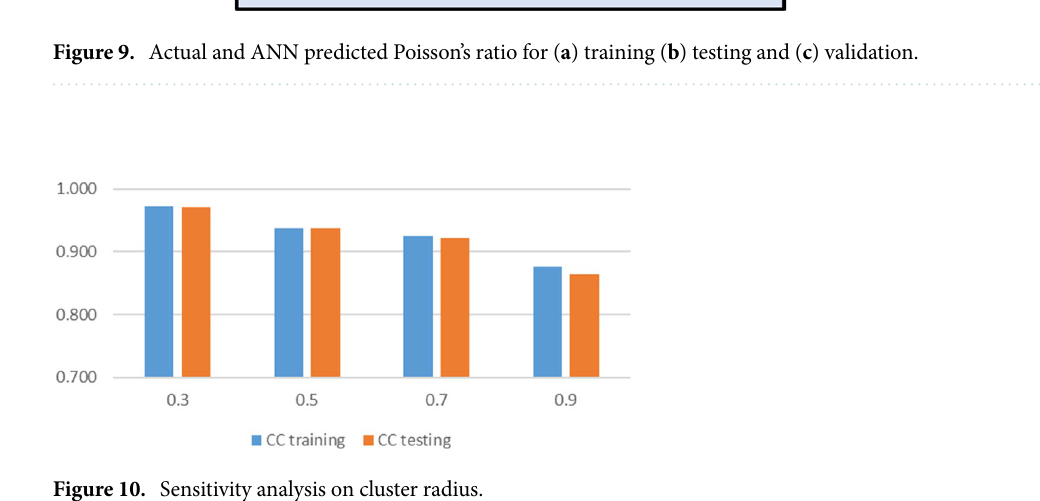
Figure 10. Sensitivity analysis on cluster